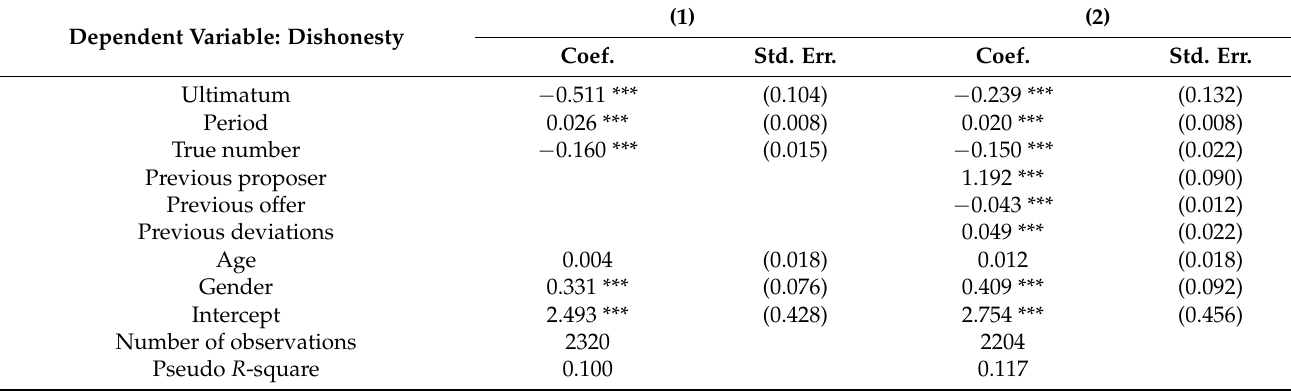
Table 2. Probit regressions on subject’s dishonesty.